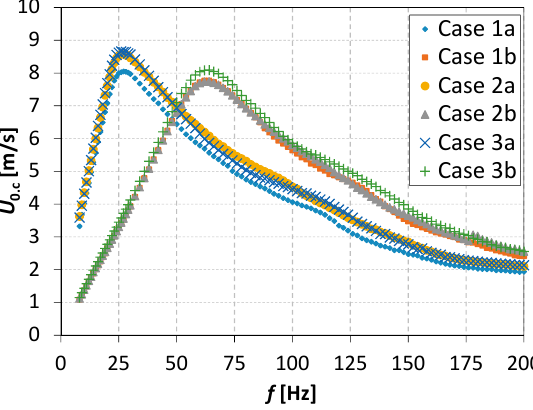
Figure 4. The centerline momentum velocity as a function of frequency at constant apparent power of P = 4 W.